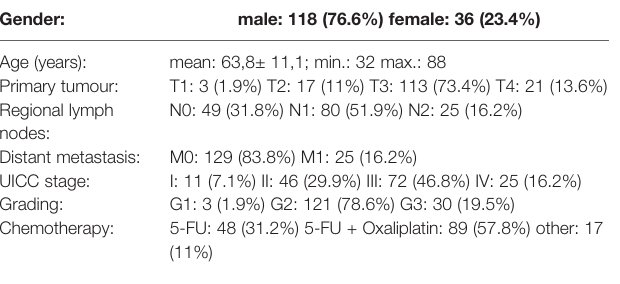
TABLE 1 | Clinical characteristics of the studied patient